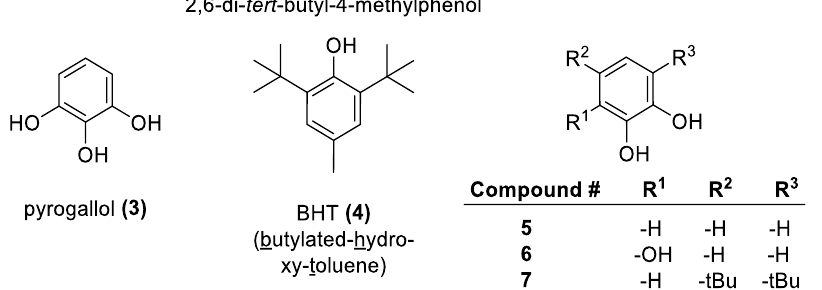
Figure 3. Structure of common phenol-based antioxidants [87]. Phenolic Acids Phenolic acids are